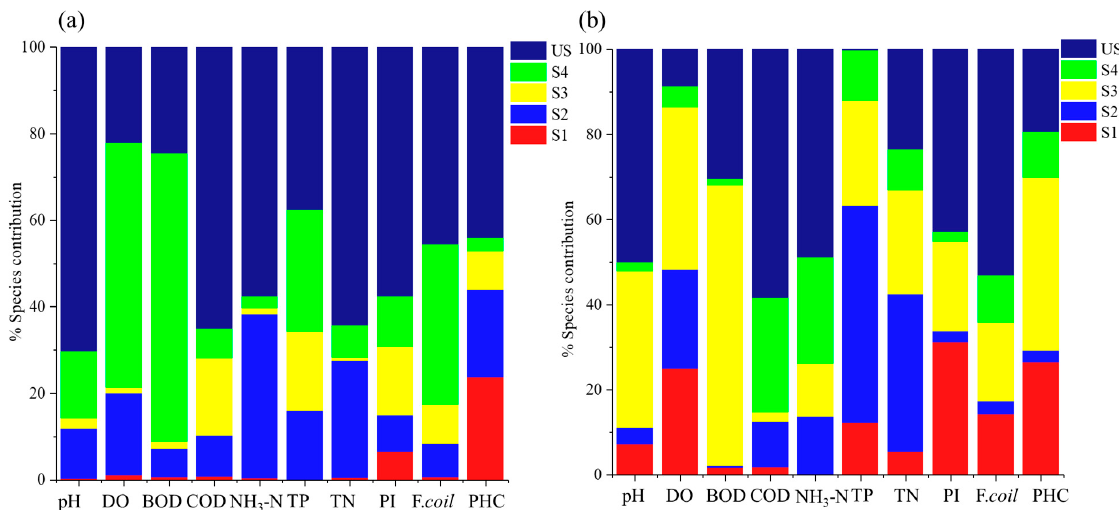
Figure 4. Contributions of pollution sources for ten studied variables estimated based on the absolute principal component score-multiple linear regression (APCS-MLR) model in the LP ( a ) and HP ( b ) zones. The S1, S2, S3, S4, and US in the LP zone were identified as point source pollution from petrochemical sewage, non-point source pollution from agricultural activity, pollution source of fecal matter, point source pollution of domestic sewage, and one undefined source, respectively. The S1, S2, S3, S4, and US in the HP zone were identified as point source pollution of hybrid wastewater discharged, non-point source of pollution of the overland runoff, point source pollution of domestic sewage, point source pollution of industrial sewage, and one undefined source, respectively.